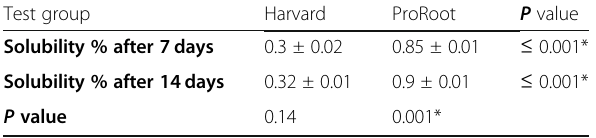
Table 1 The mean and standard deviation values of the changes in solubility (percent mean weight changes) of the two tested cements stored in STF at 7 and 14 days Test group